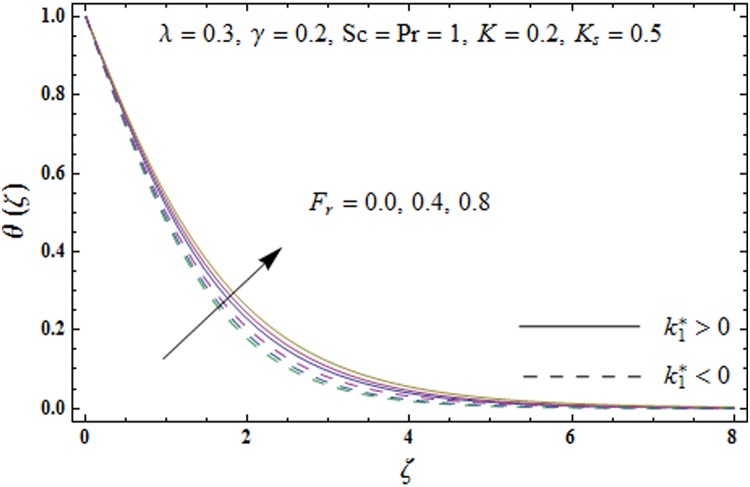
Plots of temperature field θ(ζ) for inertia coefficient Fr.